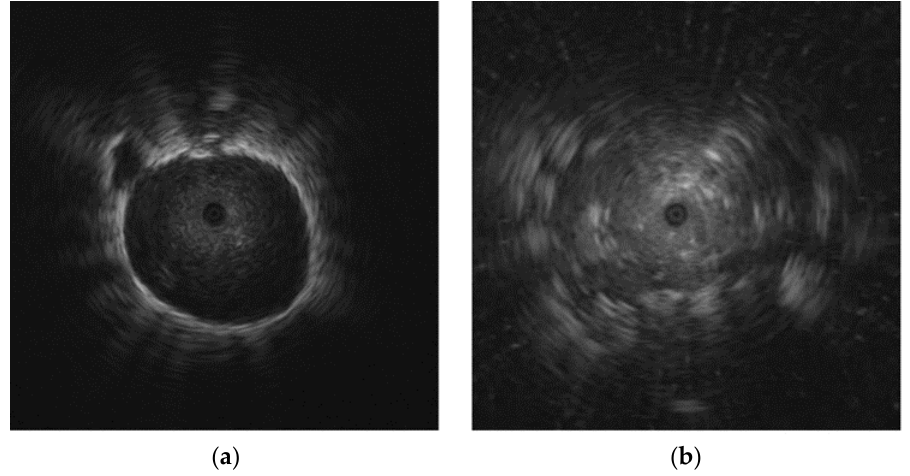
Figure 1. Examples of different pulmonary lesion patterns in EBUS images: ( a ) benign lesion; ( b ) malignant lesion (benign and malignant lesions were confirmed after core needle biopsy). Table 1. Clinical details of the patients.